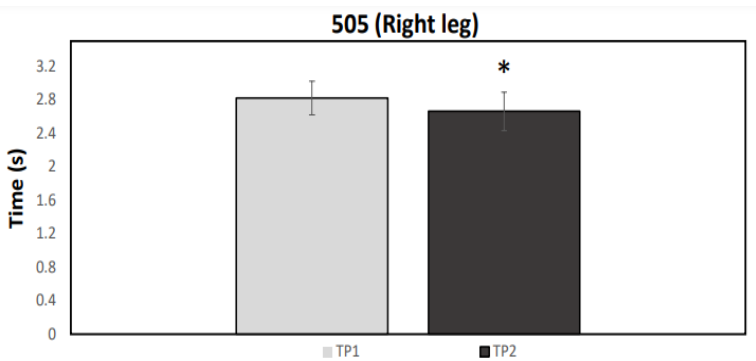
Figure 1. Mean values for the 505 COD test performance for the right leg during the two testing points (TP1 and TP2). * Statistically significant difference ( p < 0.05).